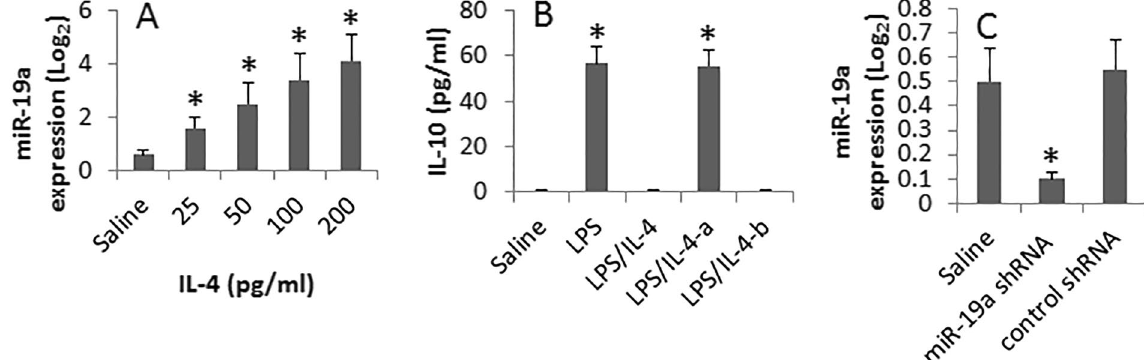
Figure 4. miR-19a mediates IL-4-suppressed expression of IL-10 in B cells. B cells were isolated from the peripheral blood samples of healthy subjects. ( A ) The cells were stimulated with IL-4 (the doses are denoted on the X axis) overnight. The bars (mean ± SD) indicate the miR-19a levels (by RT-qPCR). ( B ) Wild and miR-19a- deficient B cells were stimulated with LPS (10 µ g/ml) or LPS/IL-4 (200 ng/ml) for 48 h in the culture. The bars indicate the levels of IL-10 in B cell culture supernatant ( B ; by ELISA). ( A ) miR-19a-deficient B cells. ( B ) B cells were treated with control shRNA. ( C ) The bars show the RNAi results of miR-19a in B cells ( C ; by RT-qPCR). * p < 0.01, compared with the saline group. The data are representatives of 3 independent experiments.